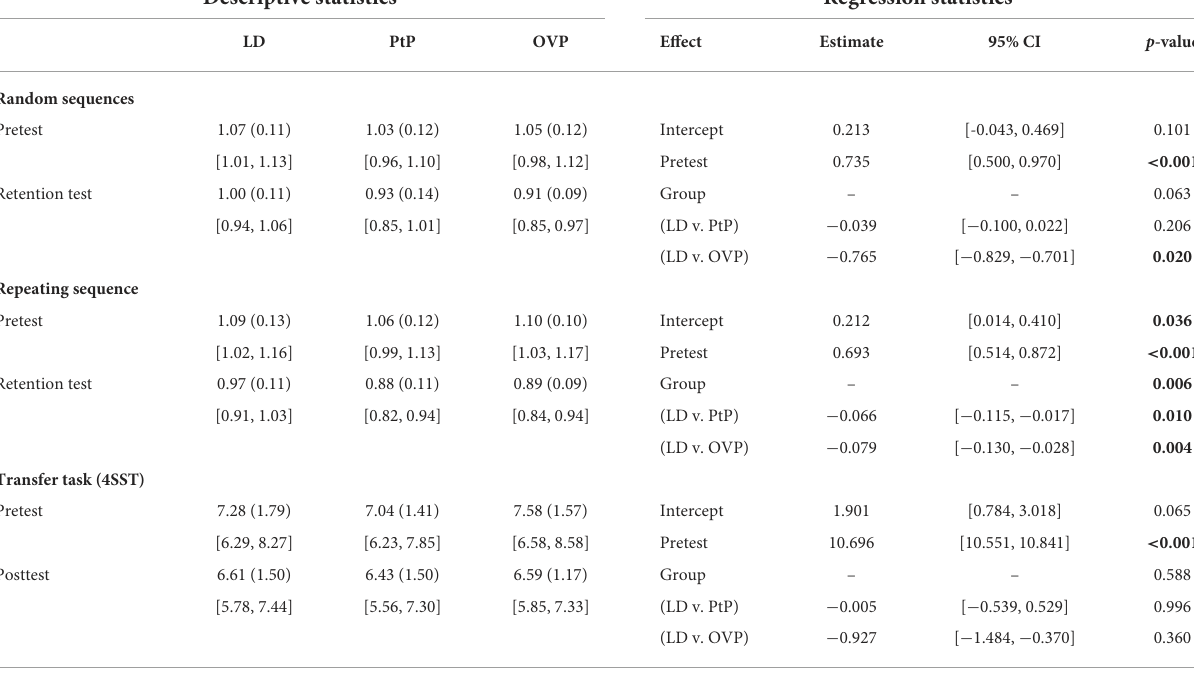
TABLE 2 Learning (i.e., retention) of the Serial Reaction Time Task (SRTT) and transfer effects on the Four Square Step Test (4SST).